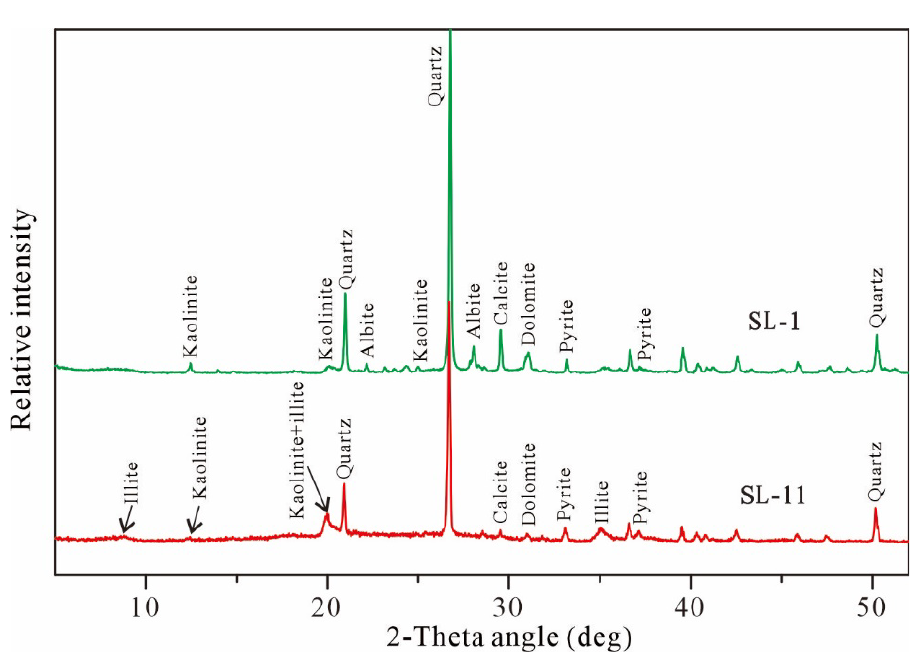
Figure 4. X-ray diffractogram (XRD) patterns of minerals in selected samples to show mineral as- semblage.